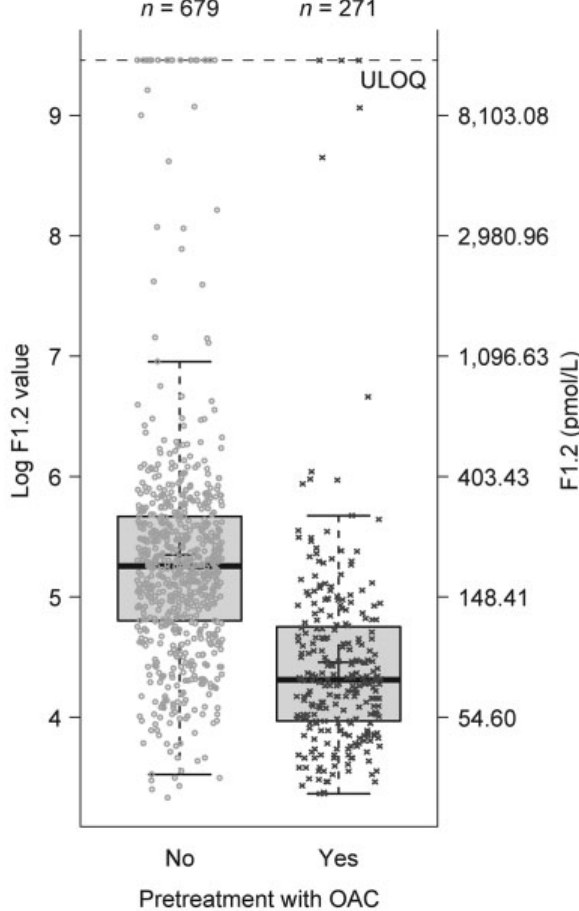
Fig. 2 In fl uence of pretreatment with OACs on F1.2 levels at baseline. F1.2, prothrombin fragment 1 þ 2; OAC, oral anticoagulant; ULOQ, upper limit of quanti fi